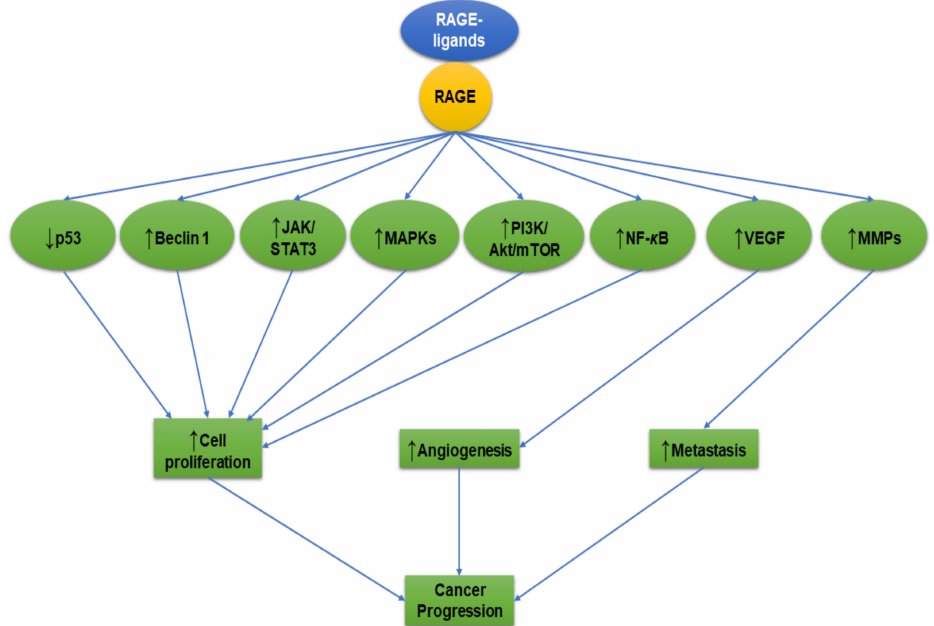
Figure 1. The e ff ects of receptor for advanced glycation end product (RAGE)-ligands on cancer progression. The interaction between RAGE-ligands / RAGE results in upregulation of the phosphatidylinositide 3-kinase (PI3K) / protein kinase B (Akt) / mammalian target of rapamycin (mTOR), mitogen-activated protein kinases (MAPKs), matrix metalloproteinases (MMPs), vascular endothelial growth factor (VEGF), and nuclear factor kappa B (NF- κ B) pathways and downregulation of p53. These pathways play an important role in controlling the tumor cells’ proliferation, angiogenesis, and invasion. The arrow pointing up ( ↑ ) means increase or upregulation. The arrow pointing down ( ↓ ) means decrease or